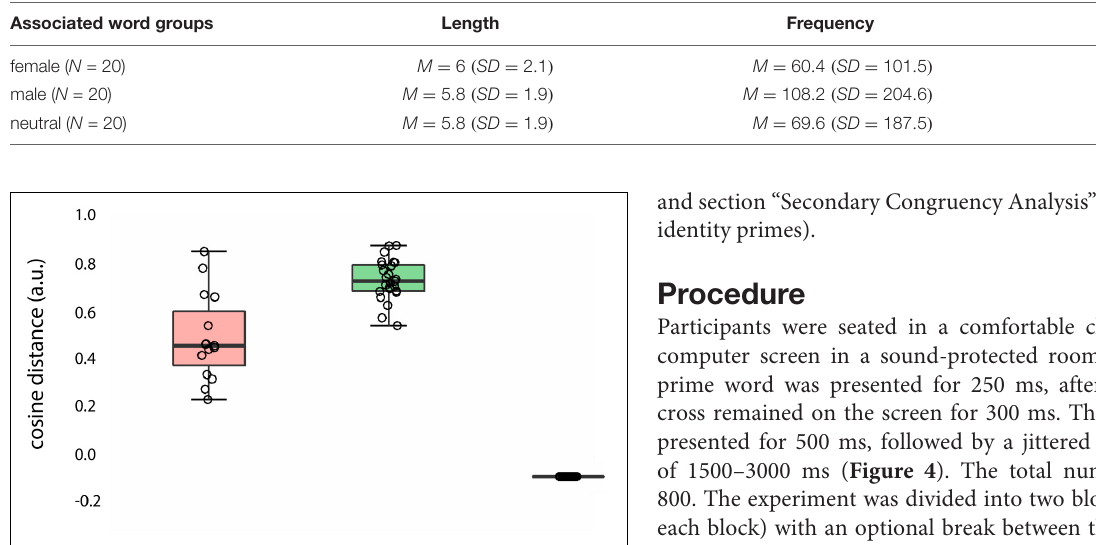
TABLE 1 | Characteristics of the words used in the priming experiment.